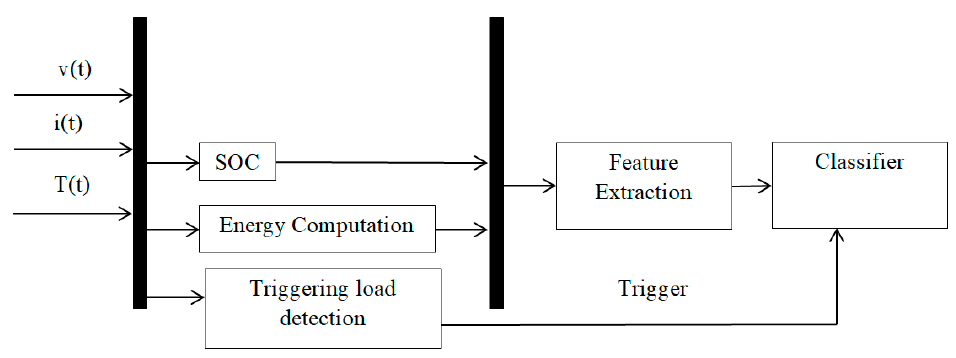
Figure 13. Recursive loop architecture to estimate of SOC and SOH using ANN .